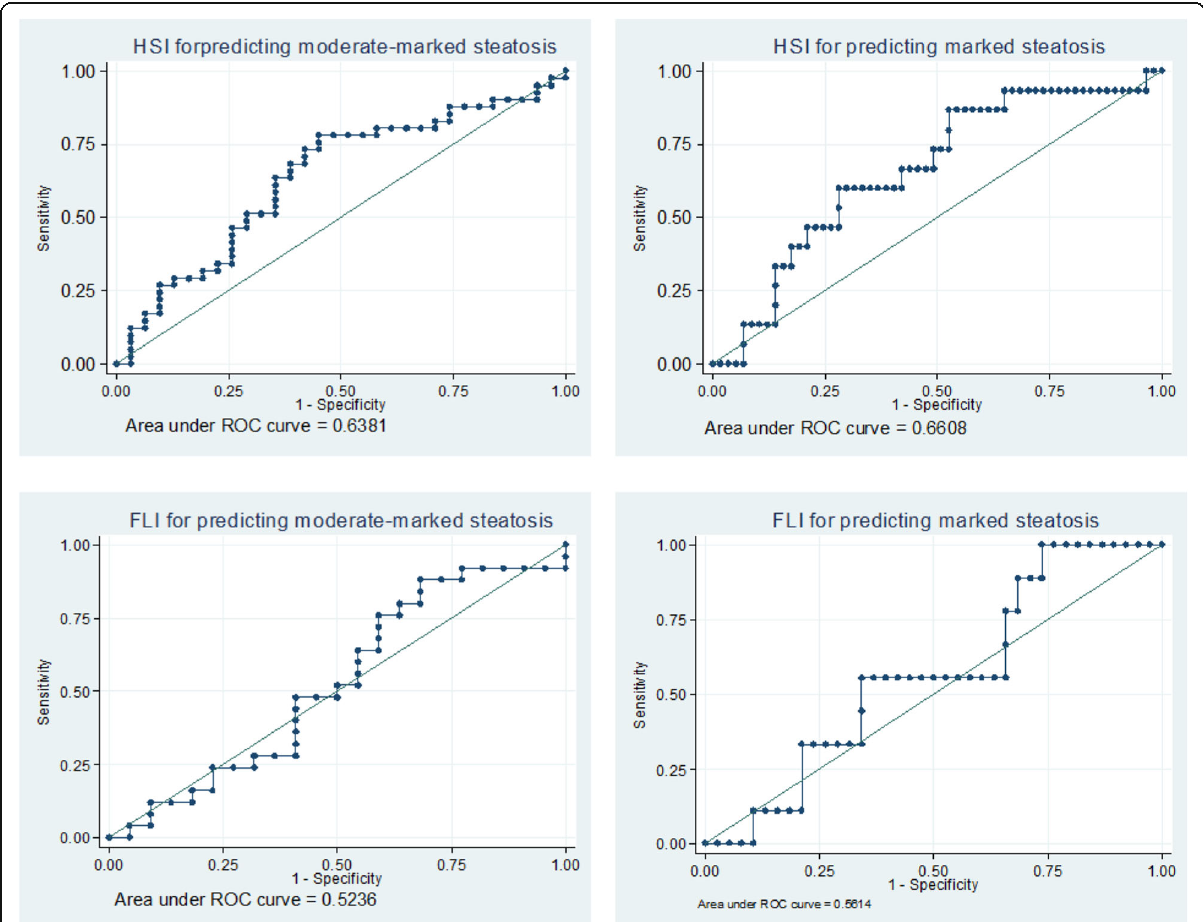
Fig. 2 ROC curve for HSI and FLI in the prediction of moderate/marked steatosis